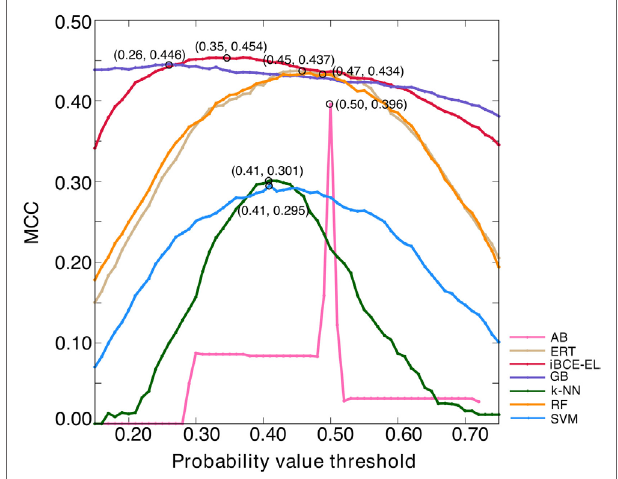
FIGURe 4 | Optimization of probability value threshold. The x - and y -axes, respectively, represent the probability value threshold and Matthews correlation coefficient. The optimal value selected for each method is shown with a circle.